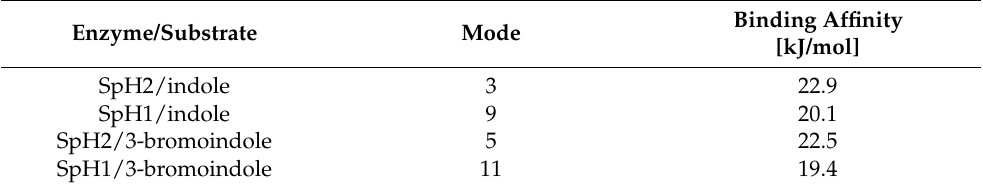
Table 2. Binding affinity of indole and 3-bromoindole to the active site of SpH2 and SpH1.